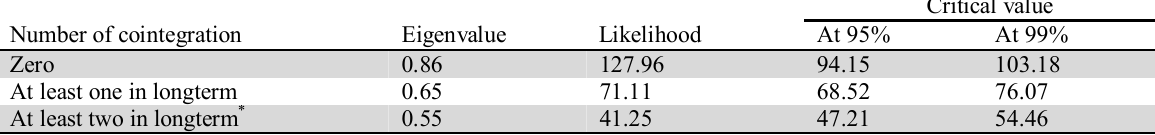
The summary of Johansen’s cointegration test for agricultural sector